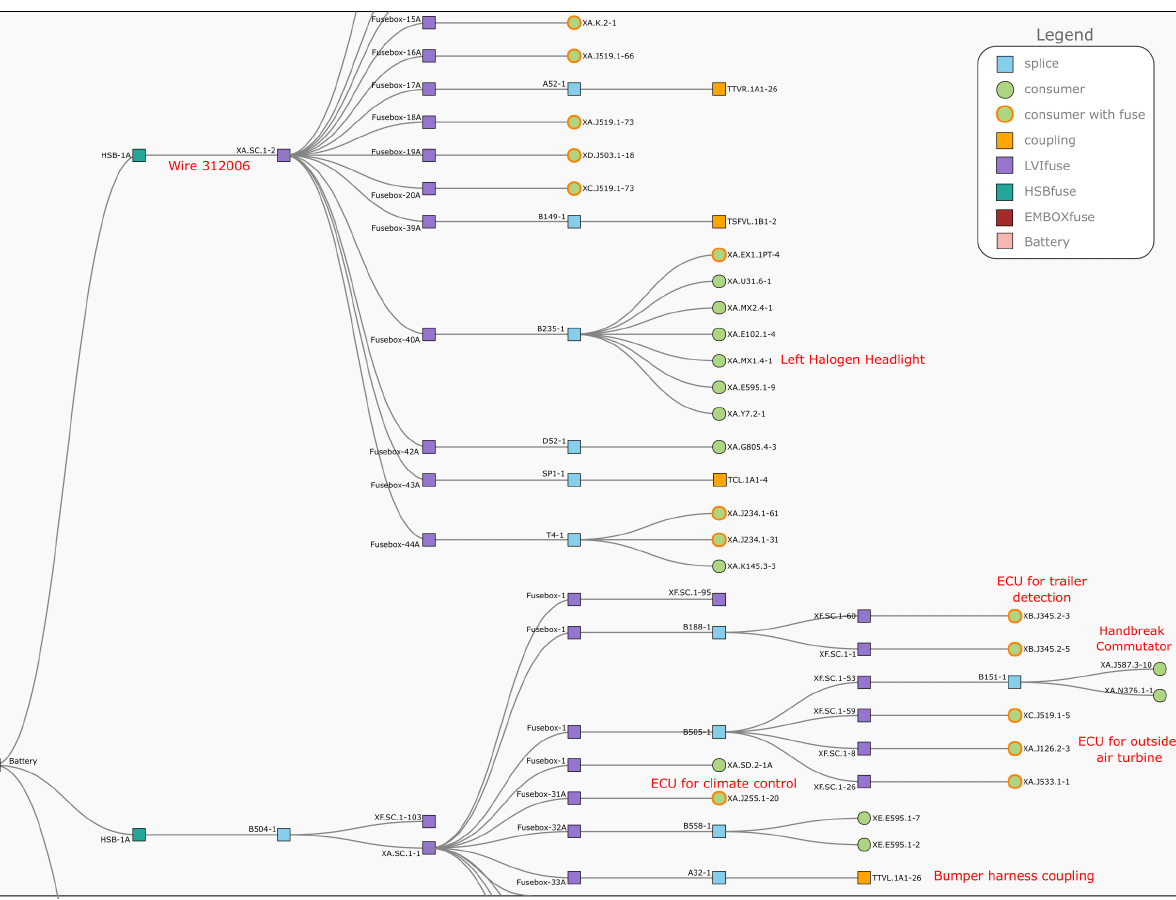
Figure 6. Extract of the Detailed View for the main harness of the SEAT Ibiza car